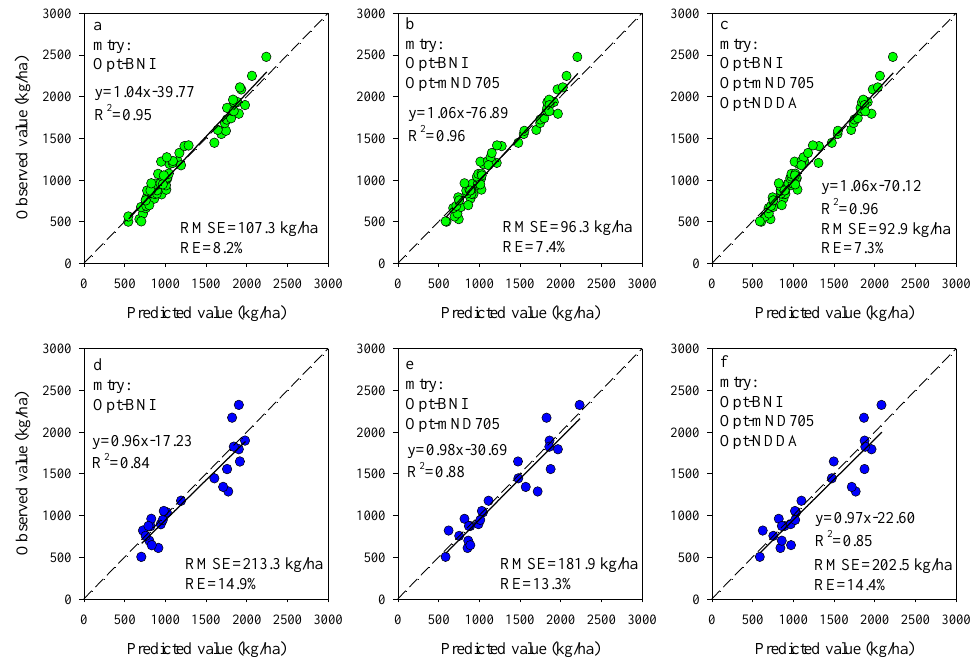
Figure 9. Optimizing the number of Opt-SIs predictors according to important scores at the tuber formation stage for training dataset ( a – c ) and testing dataset ( d – f ).